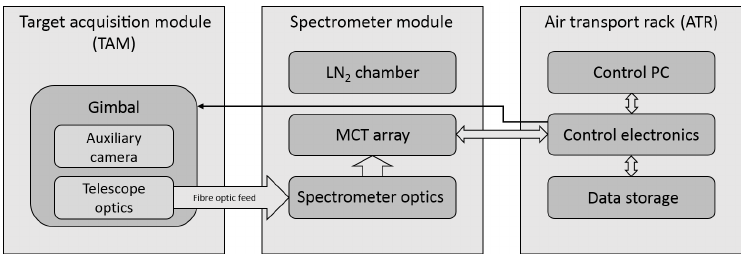
Figure 2. Block diagram showing the three main components of the GHOST instrument (described in Sect. 2) and how they interact with one another.